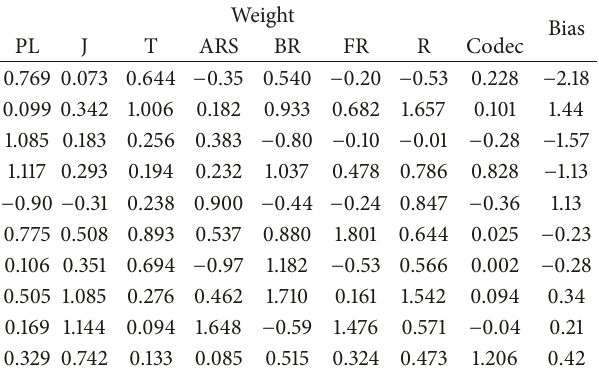
Figure 21: MSE variation across all sets. Table 25: Weight and bias value for input layer.